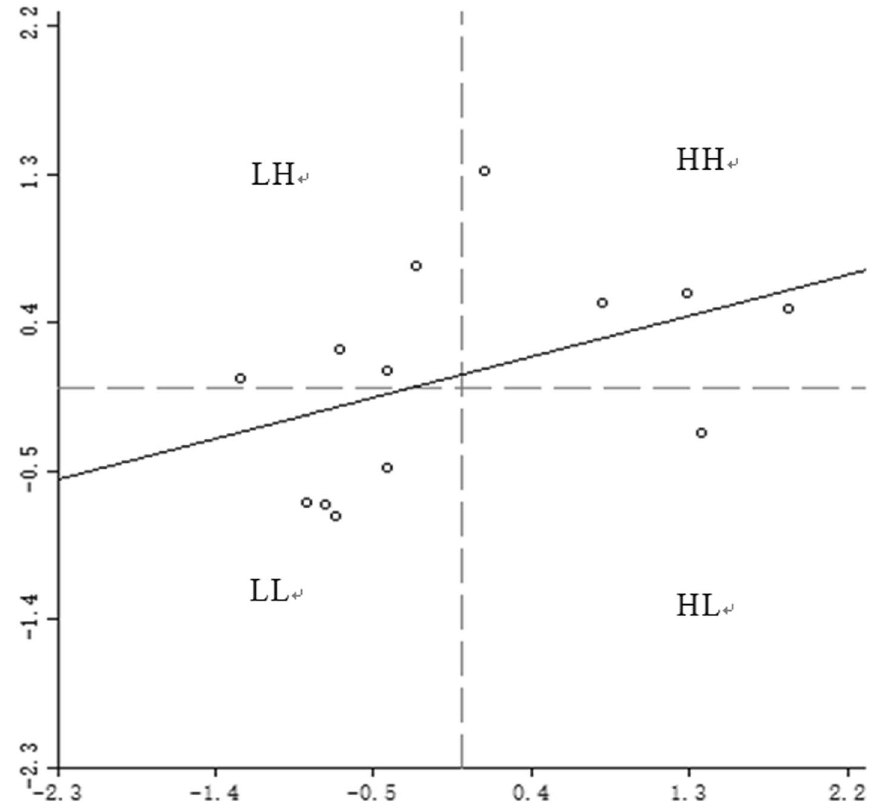
Fig. 3 Scatter chart of out-of-school hours care places in Xi’an in autumn